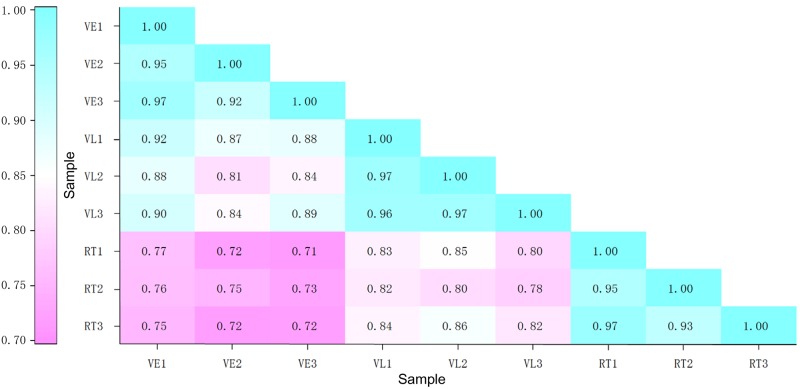
The correlation coefficients (R2) among the samples.